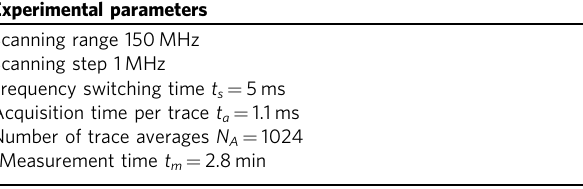
Table 1 Experimental parameters for both single-pulse and GO-coded